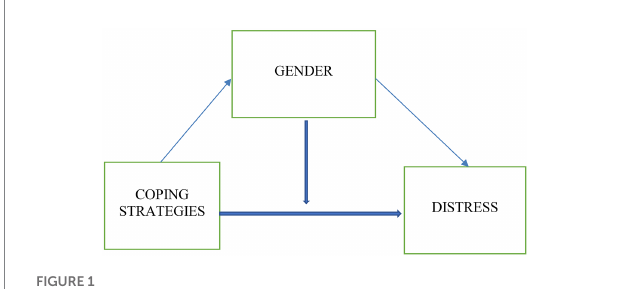
FIGURE 1 The model of the moderating effect of gender on the relationship between coping and distress.